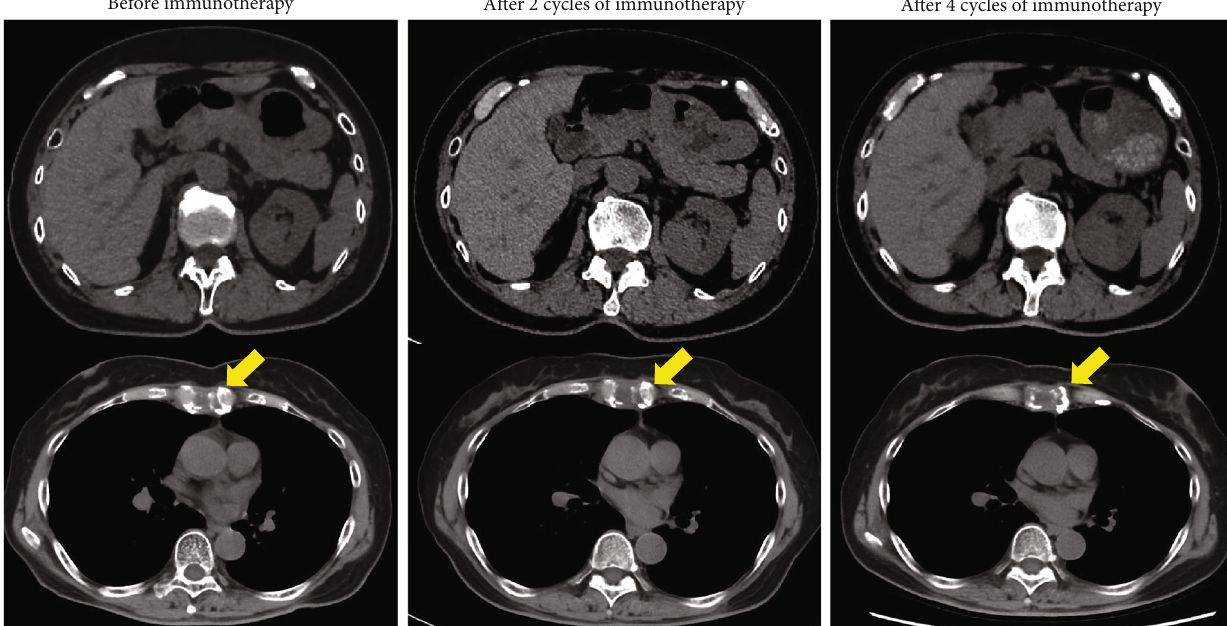
Figure 1: Hematoxylin and eosin staining and immunohistochemical staining of tissue from the renal biopsy in Case 1 ( × 400). Before immunotherapy